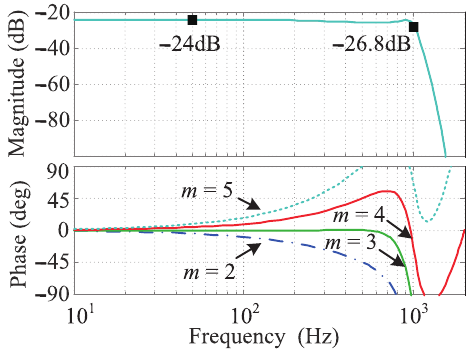
Figure 4. Bode plots of S ( z ) P ∗ ( z ) when m holds different values.